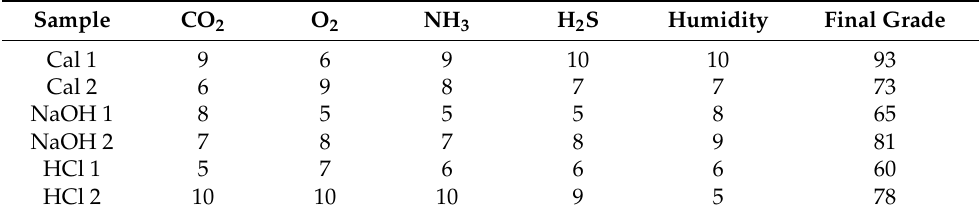
Table 7. Grade obtained by each zeolite sample and the final grade base on Equation